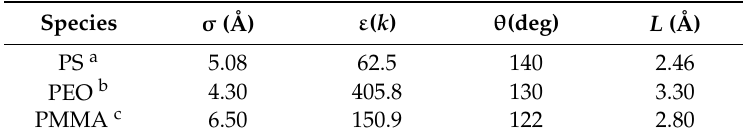
Table 1. Bond and nonbond coarse-grained force field